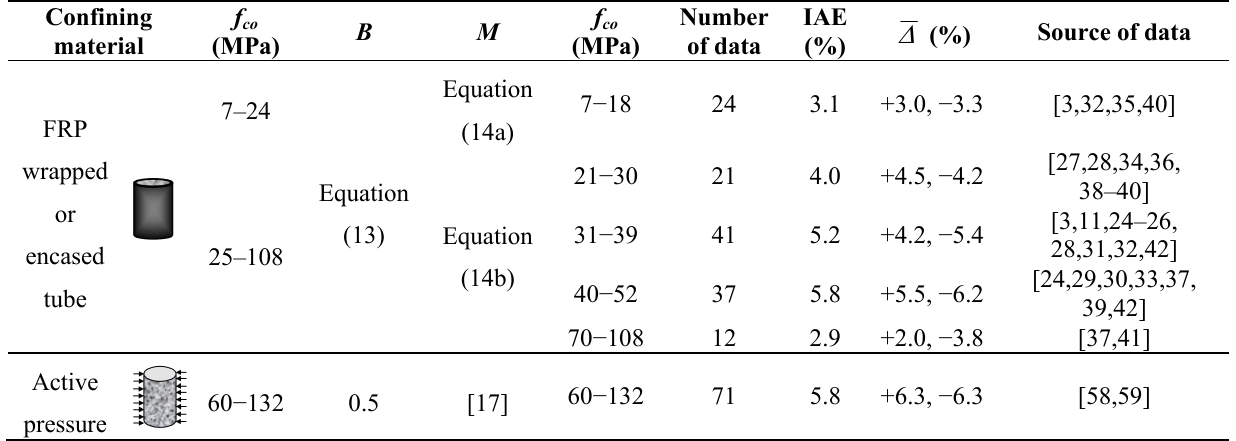
Table 2. The variation of predicted B and M